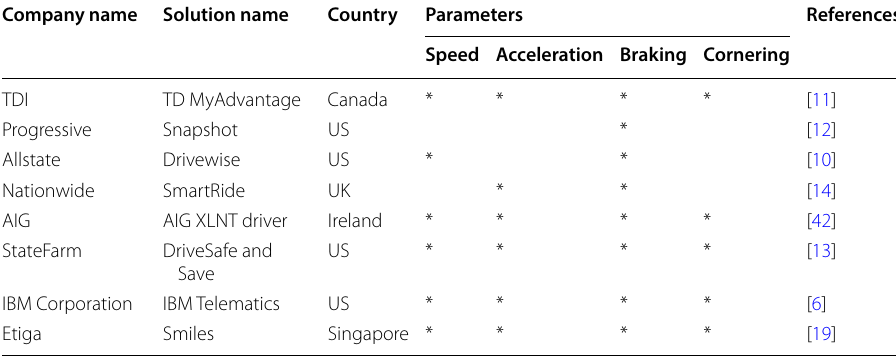
Table 3 Parameters used in industry solutions Company